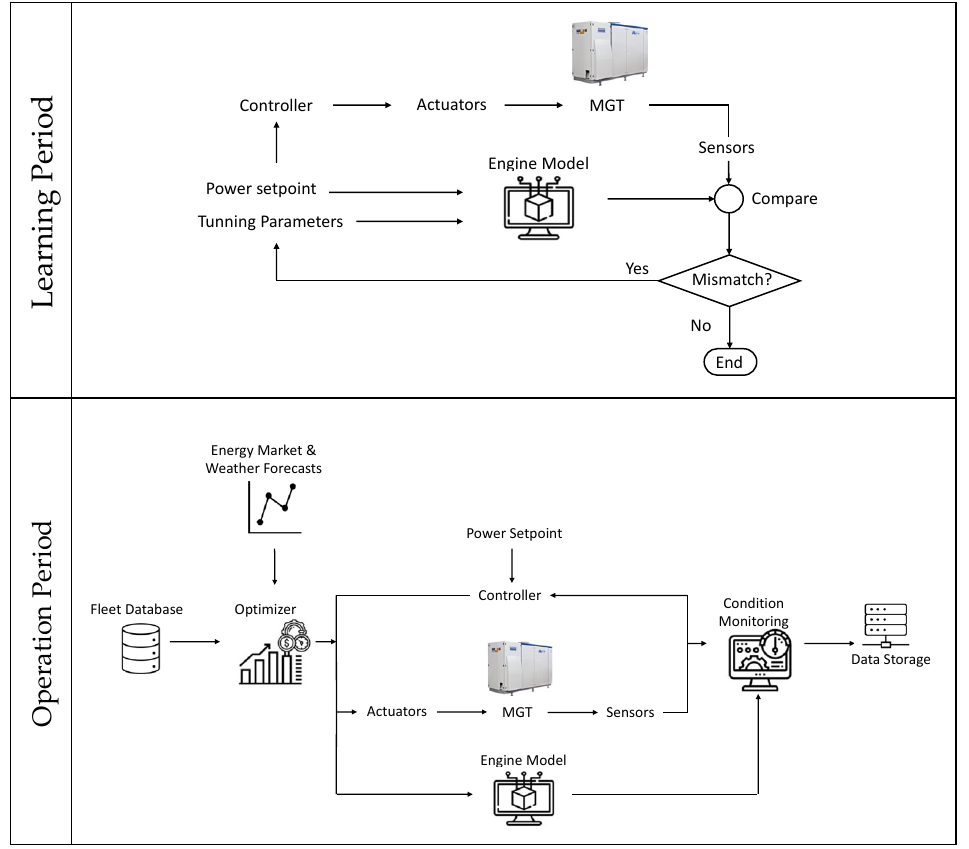
Figure 10. Micro gas turbine fleet control based on online condition monitoring. The collected data in the condition monitoring platform of Figure 10 will be recorded and analyzed to estimate the health status of the MGT, which could improve the machinery maintenance strategy by employing statistical machine performance data and operational experience and hence prevent unexpected failure in the system. Online condition moni- toring helps with predictive model improvements and, therefore, finding more optimized solutions for engine performance, which is the main role of the third pole of the system, the optimizer. Realizing the actual health condition of components of the engine, an adap- tive control scheme can be employed to compensate for the effect of deterioration. The component degradation level is assessed by the variations in the available measurements; then the information about engine health conditions is employed to adopt modified control strategies that guarantee a safe operation and limit the reduction in performance efficiency. The function of the optimizer is tied to the controller of the micro gas turbine. The controller’s function is to command the engine to operate with a specific fuel flow rate and specific rotational speed, that generates the demanded power while keeping the engines’ components safe. The controller parameters, however, are constant and usually designed based on the engine operating at its absolute healthy status. If the condition monitoring platform could provide information that indicates the engine’s deviation from its initial health, these control parameters could be modified by the optimizer and lead to